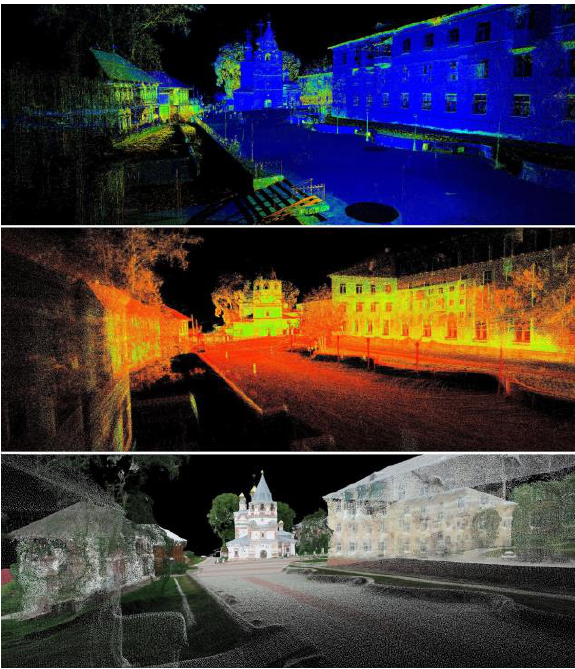
Figure 3 . Comparison of point clouds’ spatial quality between TLS, MLS, and UAV referenced datasets in Solikamsk center.